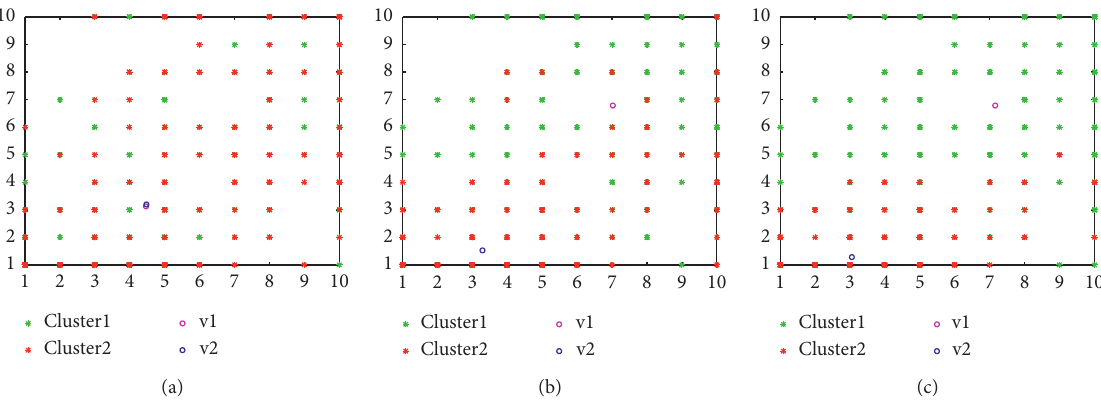
Figure 1: SNCM iteration diagram. (a) The initialized clustering result graph. (b) The clustering result graph after the first iteration. (c) The clustering result diagram of the final